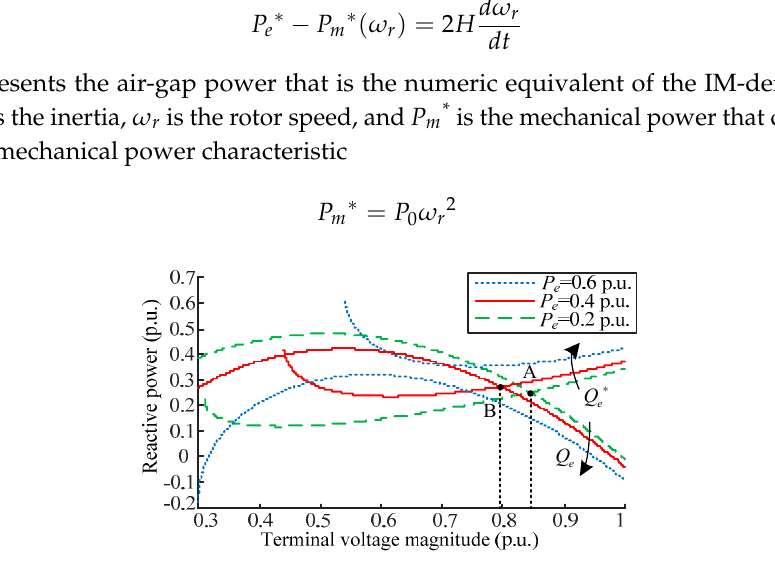
Figure 2. Q-U static characteristics of a single-IM infinite-bus system.